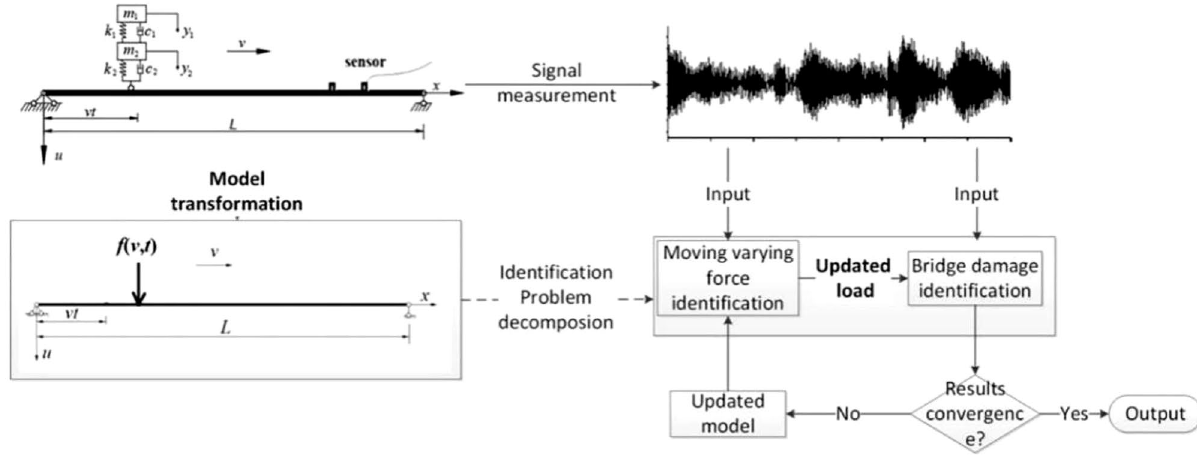
Figure 2. Framework for the conversion of damage